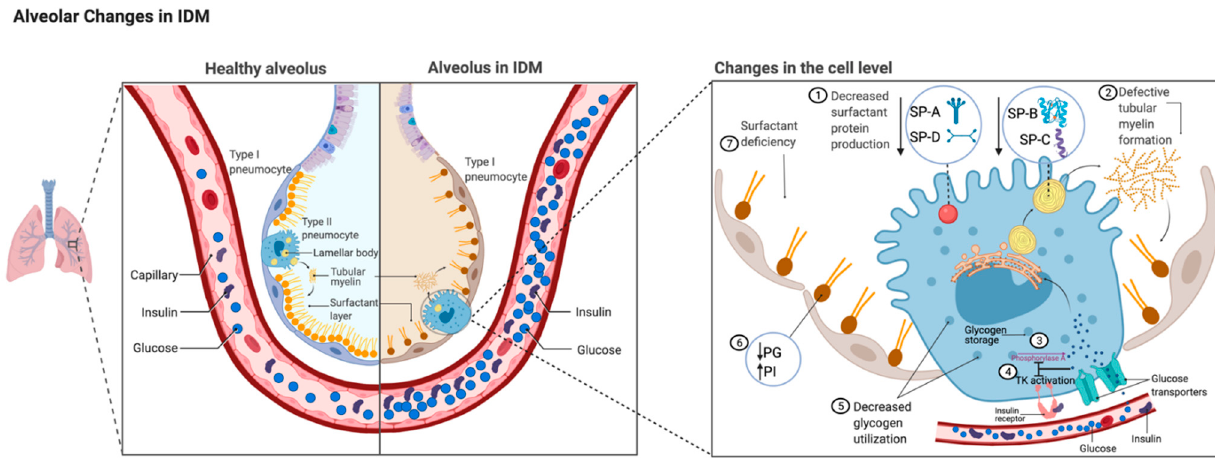
Figure 1. Comparison of alveolus between healthy lungs and infant of a diabetic mother (IDM) lung. Changes in IDM type II alveolar epithelial cell level magnified on the right. Fetal hyperglycemia and hyperinsulinemia secondary to maternal hyperglycemia affect surfactant production via different mechanisms. Hyperglycemia and hyperinsulinism are illustrated in the capillary. (1) Decreased level of surfactant proteins (SP-A, -B, -C, and -D) [42–46]. (2) Decreased level of SP-B causes abnormal tubular myelin formation. (3) Excess glucose inhibits phosphorylase A activity [47]. (4) Glucose decreases insulin receptor tyrosine kinase (TK) activity level [48]. (5) Glycogen storage is decreased due to decreased glycogen phosphorylase A activity. (6) Alterations in surfactant phospholipid synthesis affected by inadequate glucose resulting in decreased phosphatidyl glycerol (PG) and increased phosphatidyl inositol (PI) [38–40]. (7) These changes contribute to increased respiratory distress syndrome secondary to surfactant deficiency in IDMs.